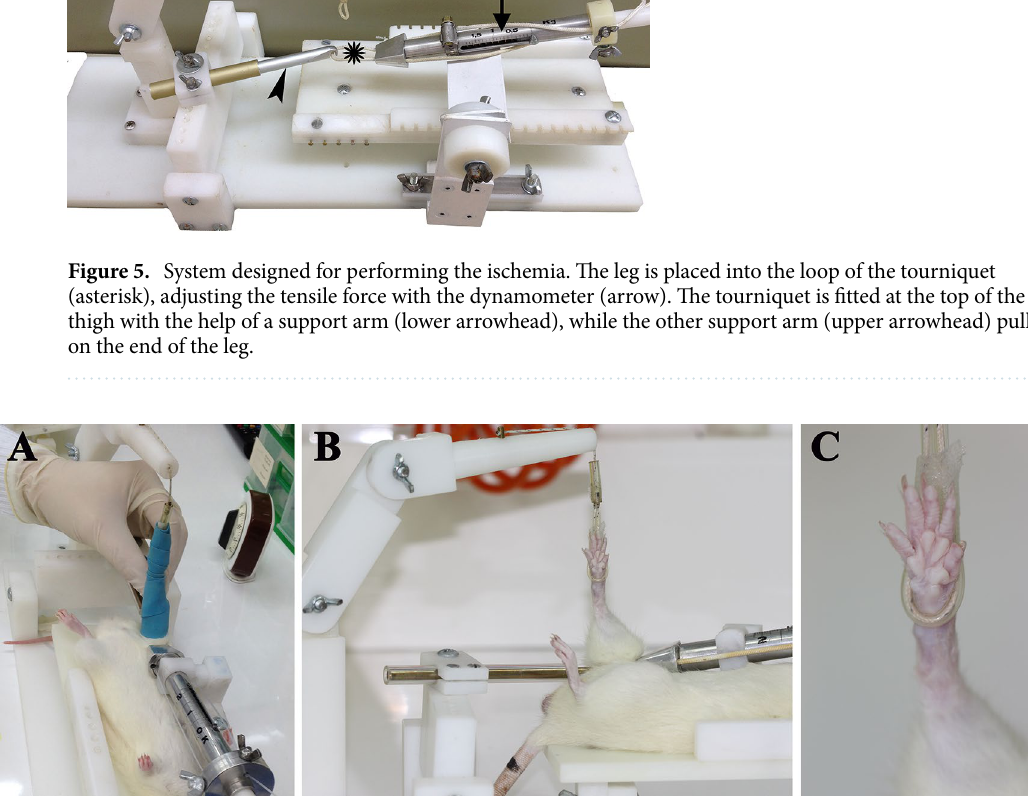
Figure 6. Procedure for inducing ischemia. Exsanguination of the leg is performed with a rubber bandage ( A ), the tourniquet is fitted to the base of the leg and the bandage removed ( B ). It is confirmed that ischemia is maintained by the observation that the leg is pale ( C